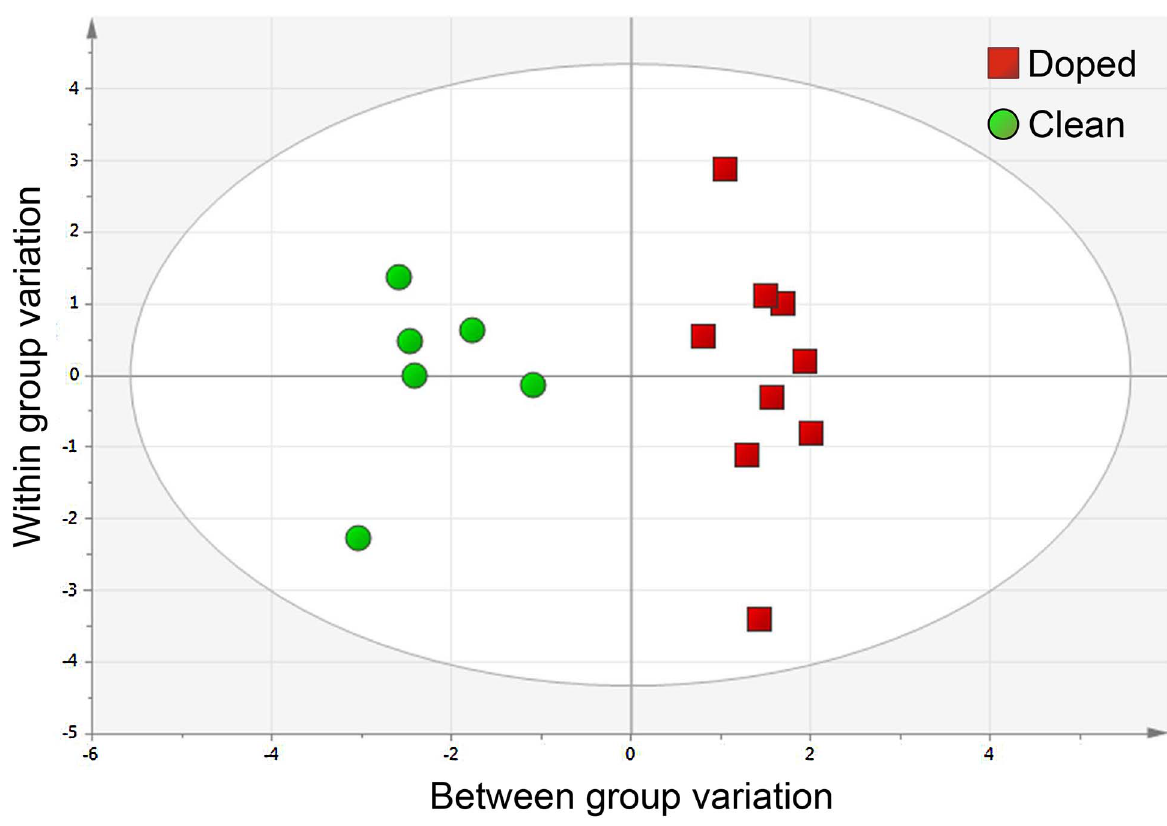
Figure 3. The OPLS-DA model scores scatter plot of combined performance and morphological separates Doped from Clean athletes. Morphological and performance variables (N=8) are used in an OPLS-DA model to separate Doped (N=9) from Clean (N=6) subjects. Regression=0.93, and prediction by cross-validation=0.92, p , 0.0001, Fisher’s exact probability test. All nine Doped subjects and six of seven Clean are correctly classified, leaving one Clean un-classified. Variables of importance are displayed in Figure 4.